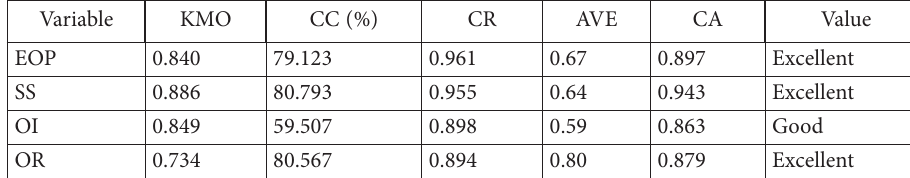
Table 2. Reliability and validity of each measurement scale (source: authors’ experiment) Variable KMO CC (%) CR AVE CA Value EOP 0.840 79.123 SS OI